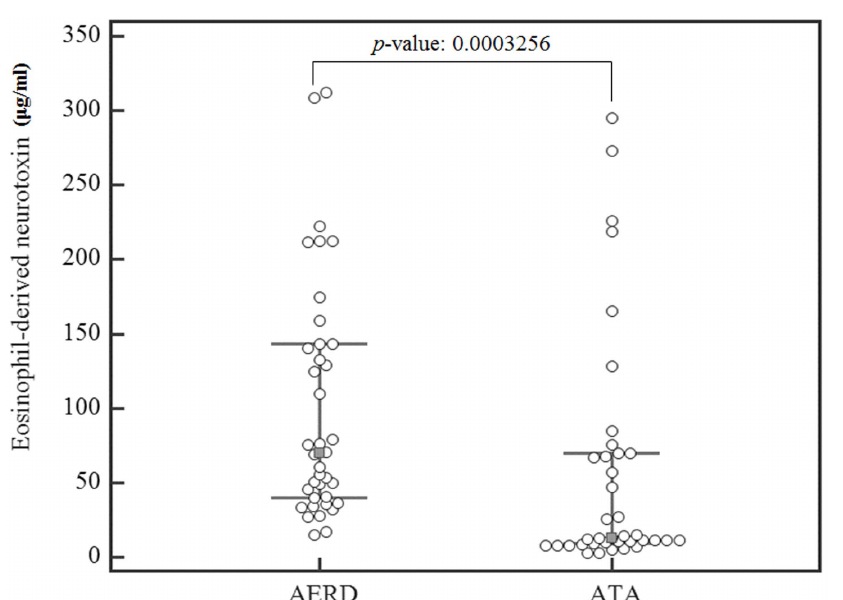
Figure 1. Box plot of the eosinophil-derived neurotoxin expression levels in AERD and ATA groups as assessed by ELISA (Error bar: 25 , 75 percentiles).